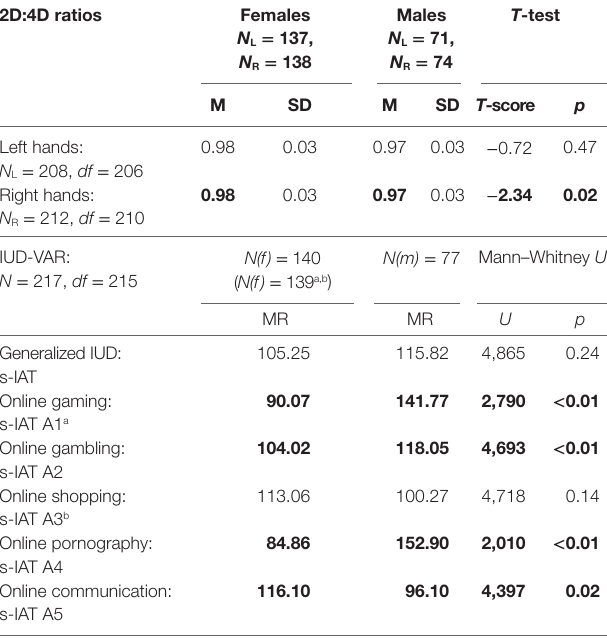
Table 2 | Gender specific differences of hand ratios ( T -test) and s-IAT scales (Mann–Whitney U Test). 2D:4D ratios